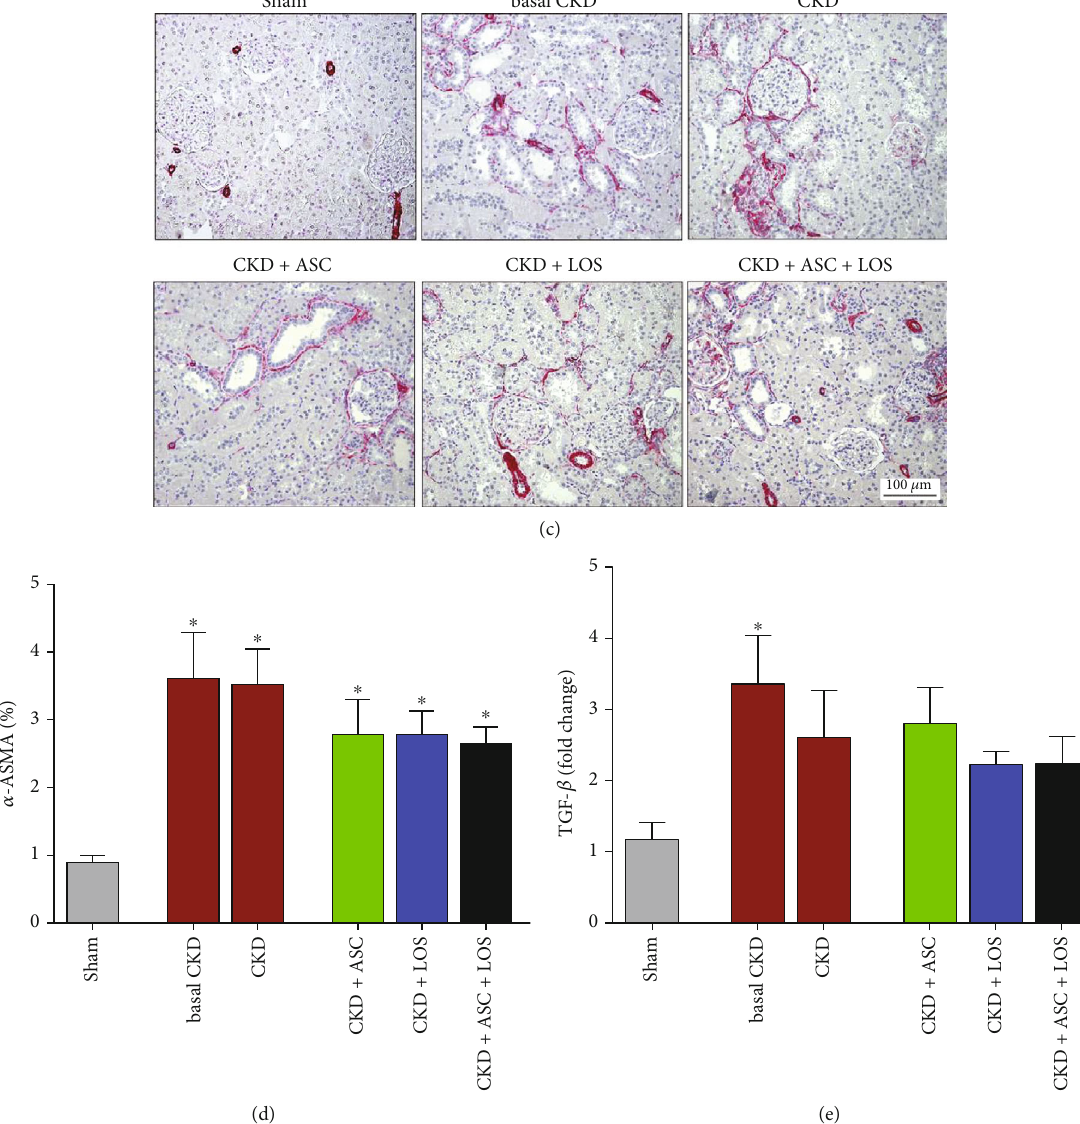
Figure 4: Interstitial fi brosis and myo fi broblast in fi ltration. (a) Illustrative microphotographs of Masson ’ s trichrome staining in the experimental groups. (b) Bar graphs representing the percentage of the renal interstitial area occupied by fi brosis in the studied animals. (c) Microphotographs illustrating the immunohistochemistry for α -ASMA to determine the presence of interstitial myo fi broblasts in the renal parenchyma of the studied animals. (d) Bar graphs representing the percentage of interstitial area occupied by α -ASMA. (e) Bar graphs representing the local renal TGF- β gene expression. Statistical di ff erences are ∗ p < 0 : 05 vs. Sham, § p < 0 : 05 vs. basal CKD, # p < 0 : 05 vs. CKD, † p < 0 : 05 vs. CKD+ ASC, and ‡ p < 0 : 05 vs. CKD+